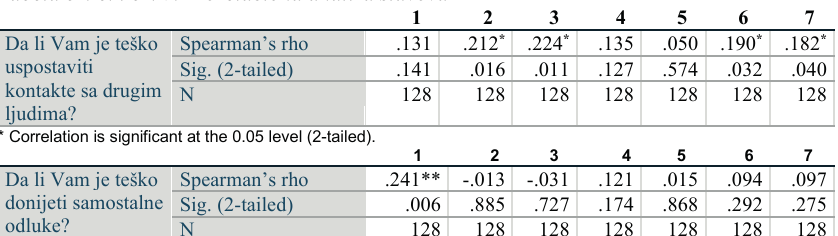
Tabela br. 6. i br. 7. Korelaciona analiza stavova